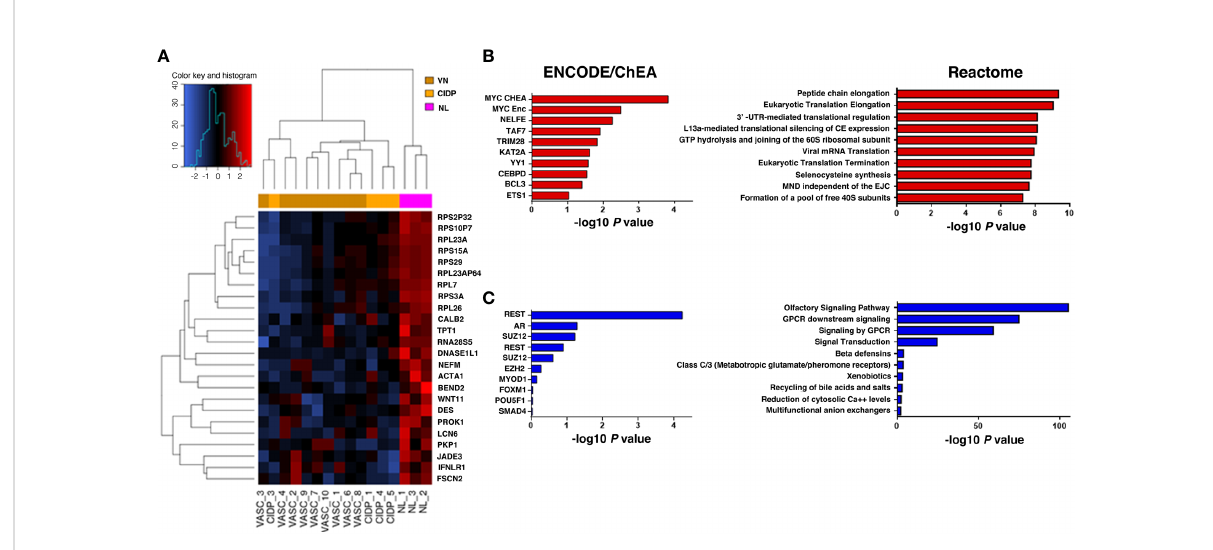
FIGURE 2 Heatmap representing hierarchical clustering of the 16 samples (columns) and gene (rows) detected as highly differentially expressed. The expression level of each gene has been standardized by subtracting the gene ’ s mean expression level and dividing by the standard deviation across all samples. The scaled expression value is plotted in red-blue scale colour, with red indicating higher expression and blue lower expression in NL patients (A) . Functional enrichment analysis on upregulated genes ( B , red) identi fi ed MYC as the top ranked upstream transcription factor in our up-DEGs (ENCODE/ChEA consensus database), while enriched downstream pathways were those related to ribosomal biogenesis and mRNA translation (Reactome database). Downregulated genes ( C , blue) were mainly associated with olfactory and GPCR signalling (Reactome database), highlighting REST as the most relevant transcription factor enriched in our analysis (ENCODE/ChEA consensus